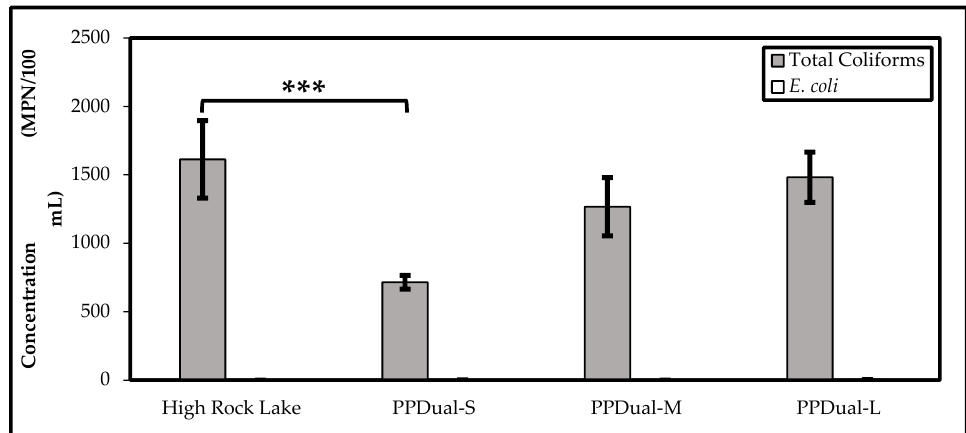
Figure 4. Total coliforms and E. coli concentration after PPDual-S, PPDual-M, and PPDual-L filtration. *** Significant difference.